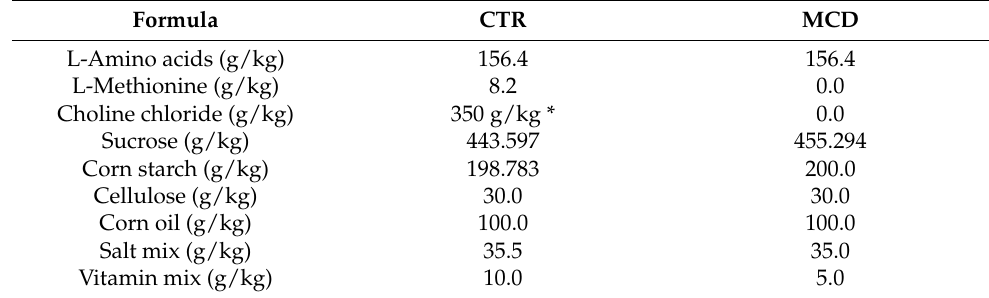
Table 1. MCD diet and MCD control diet